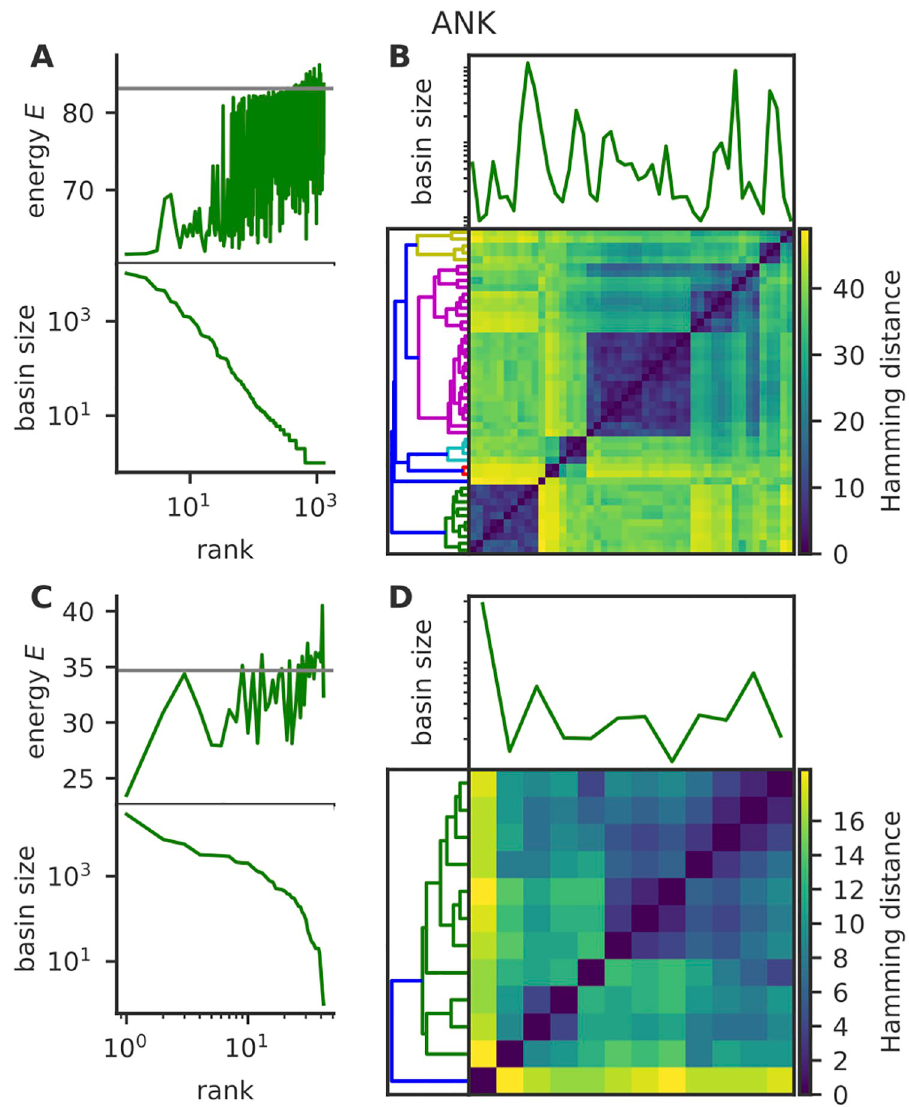
Fig 5. Interactions within and between repeats sculpt a rugged energy landscape with many local minima. Local minima were obtained by performing a zero-temperature Monte-Carlo simulation with the energy function in Eq (2), starting from initial conditions corresponding to naturally occurring sequences of pairs of consecutive ANK repeats. A, bottom) Rank-frequency plot of basin sizes, where basins are defined by the set of sequences falling into a particular minimum. A, top) energy of local minima vs the size-rank of their basin, showing that larger basins often also have lowest energy. Gray line indicates the energy of the consensus sequence, for comparison. B) Pairwise distance between the minima with the largest basins (comprising 90% of natural sequences), organised by hierarchical clustering. The panel right above the matrix shows the size of the basins relative to the minima corresponding to the entries of the distance matrix. A clear block structure emerges, separating different groups of basins with distinct sequences. C-D) Same as A) and B) but for single repeats. Since single repeats are shorter than pairs (length L instead of 2 L ), they have fewer local energy minima, yet still show a rich multi-basin structure. Equivalent analyses for LRR and TPR are shown in S3 and S4